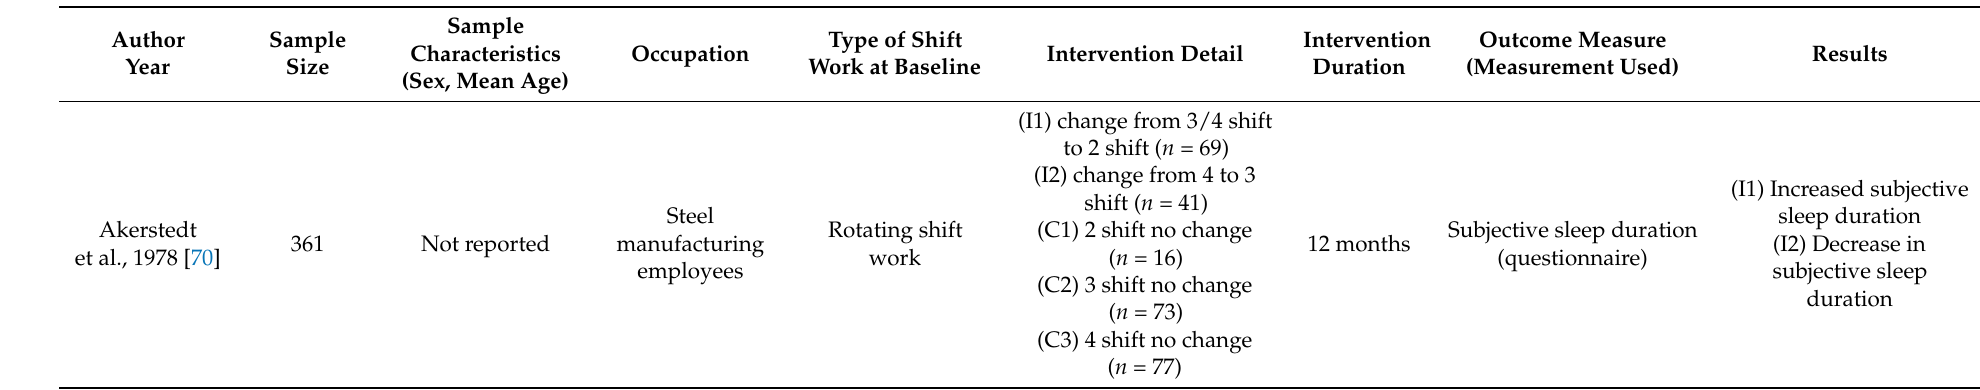
Table 3. Studies investigating schedule change